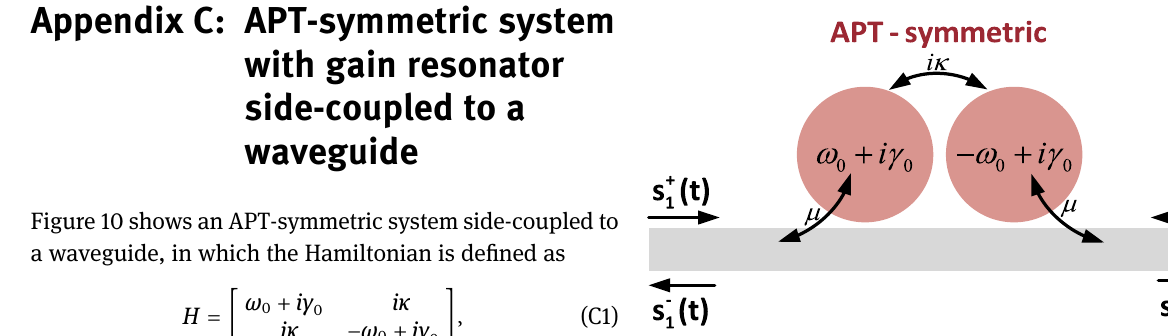
Figure 9: Power reflection and transmission spectrum for ω 0 = 1 , γ 0 = 0 . 05 , γ (a) Double Lorentzian resonances with κ < κ EP . (b) Single Lorentzian resonance κ = κ EP . (c) Single Lorentzian resonance with κ > κ EP .